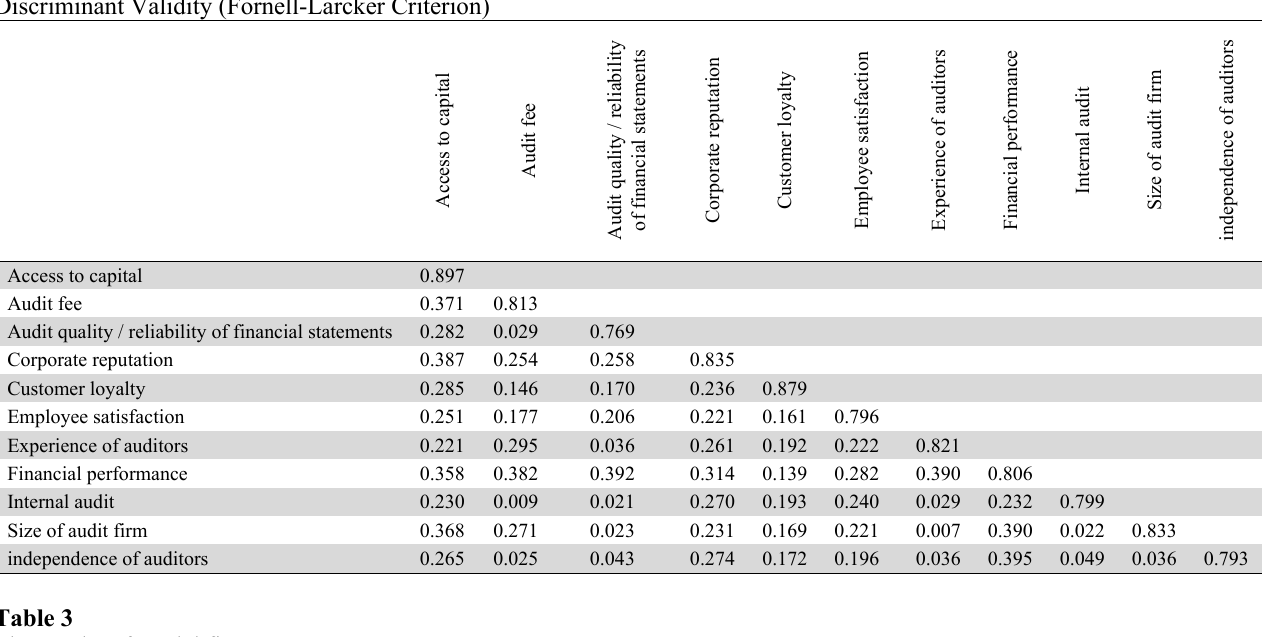
The results of model